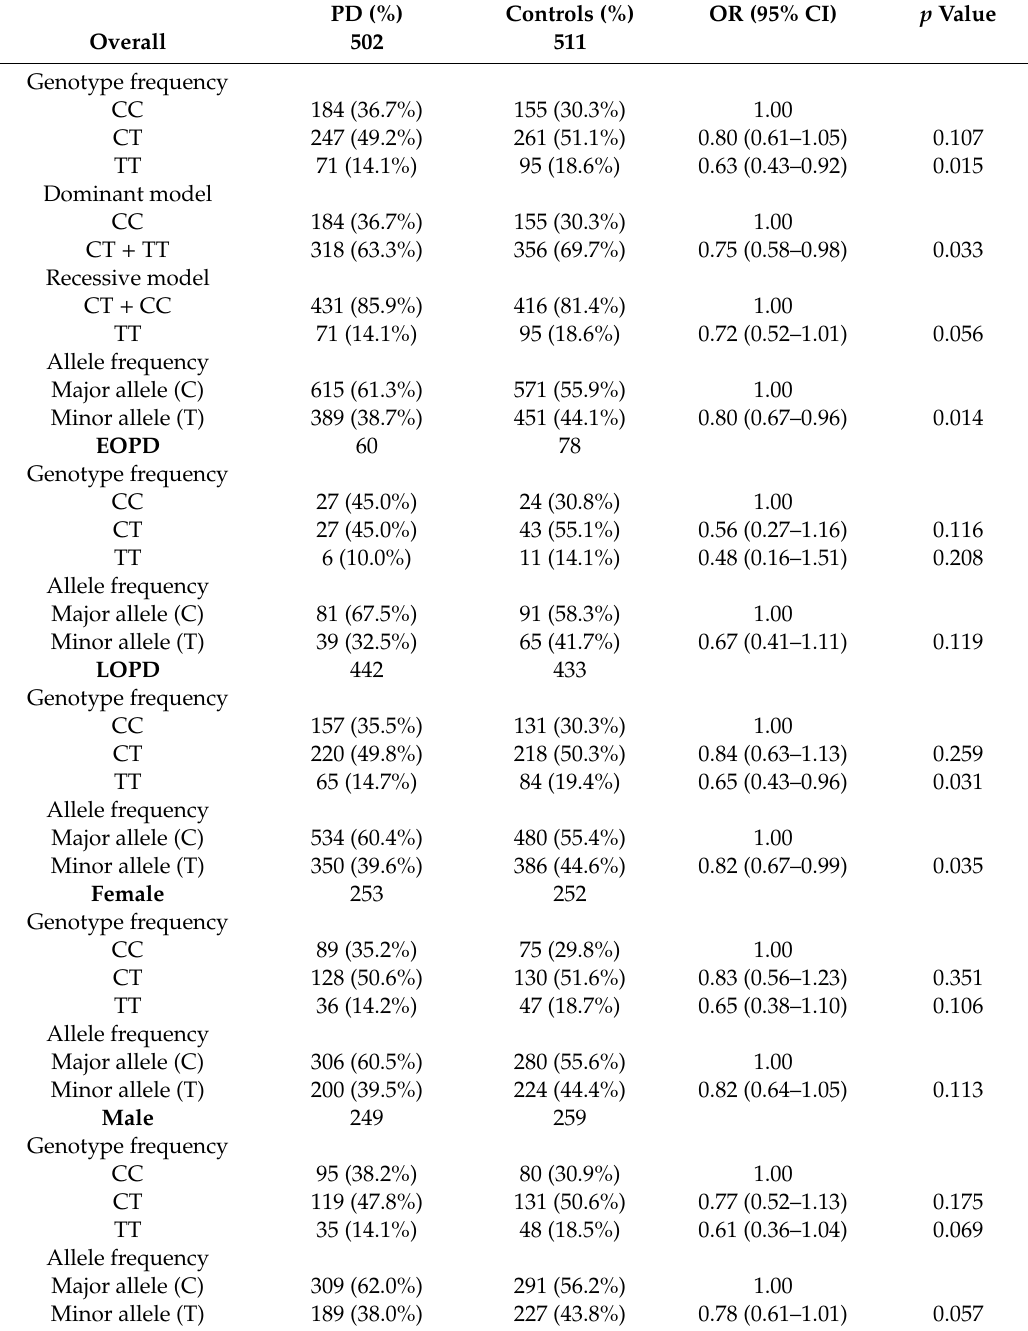
Table 2. Genotype and allele frequencies of CSF1 rs1058885 polymorphism among Parkinson’s disease (PD) patients and control subjects in